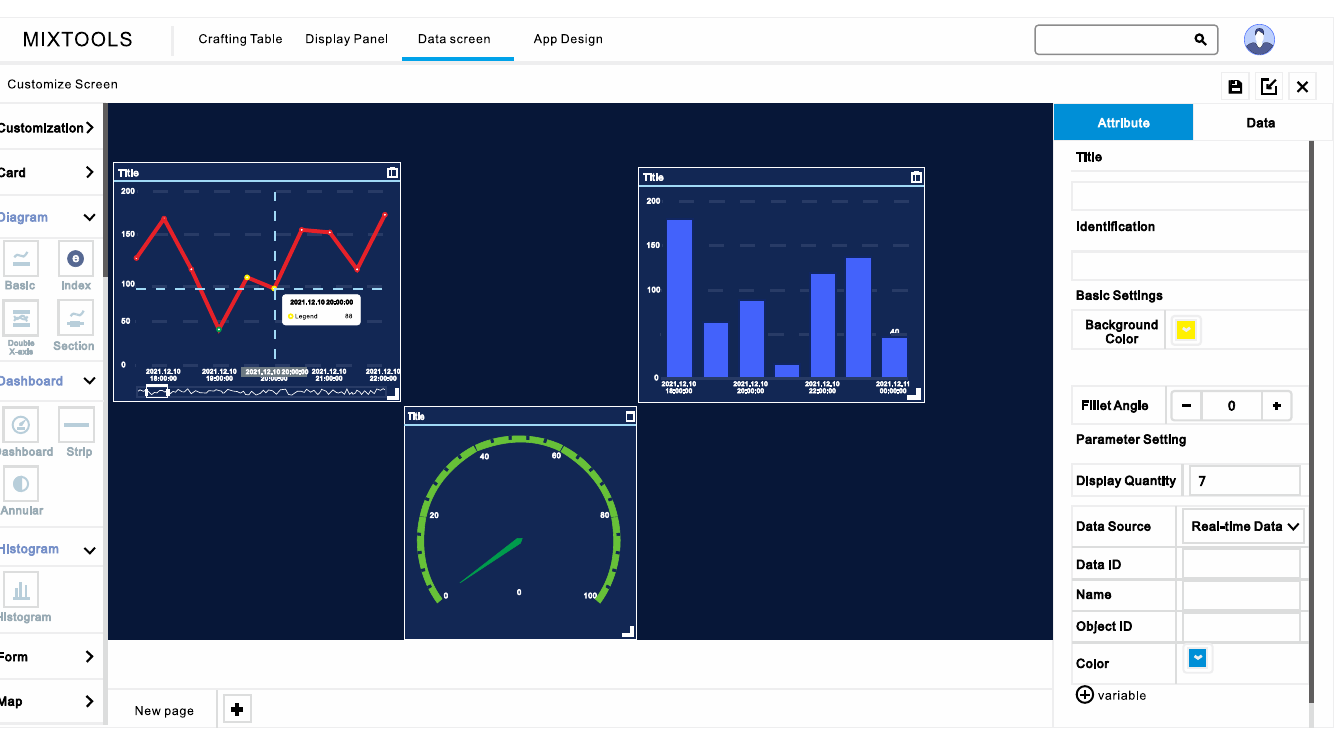
Fig 6. Customize visualization